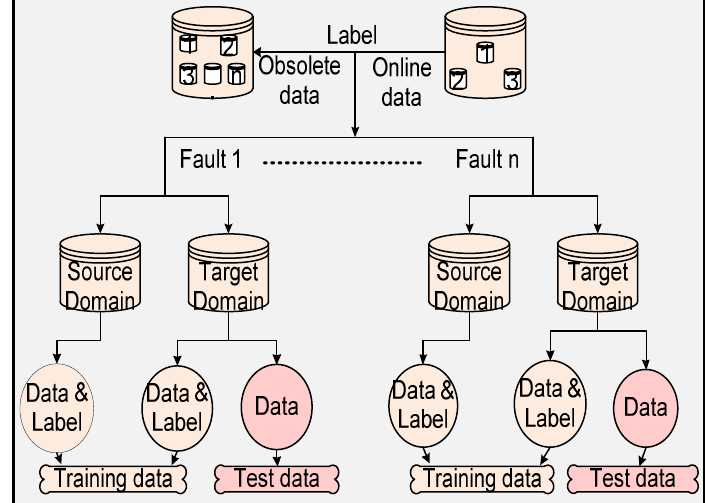
Figure 2. The flowchart of data splitting.